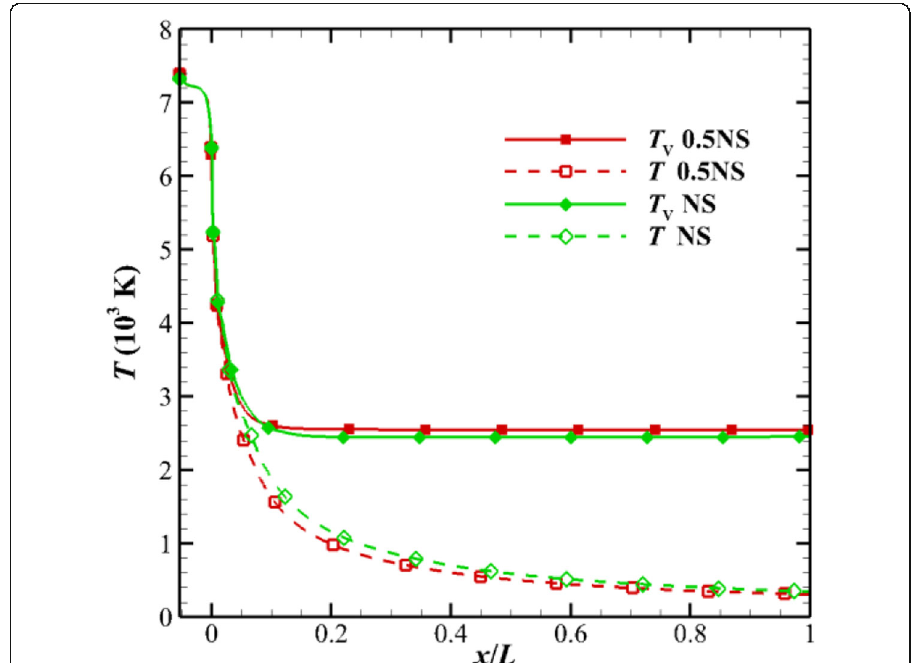
Fig. 6 Comparison of the centerline temperature distribution based on the FD-21